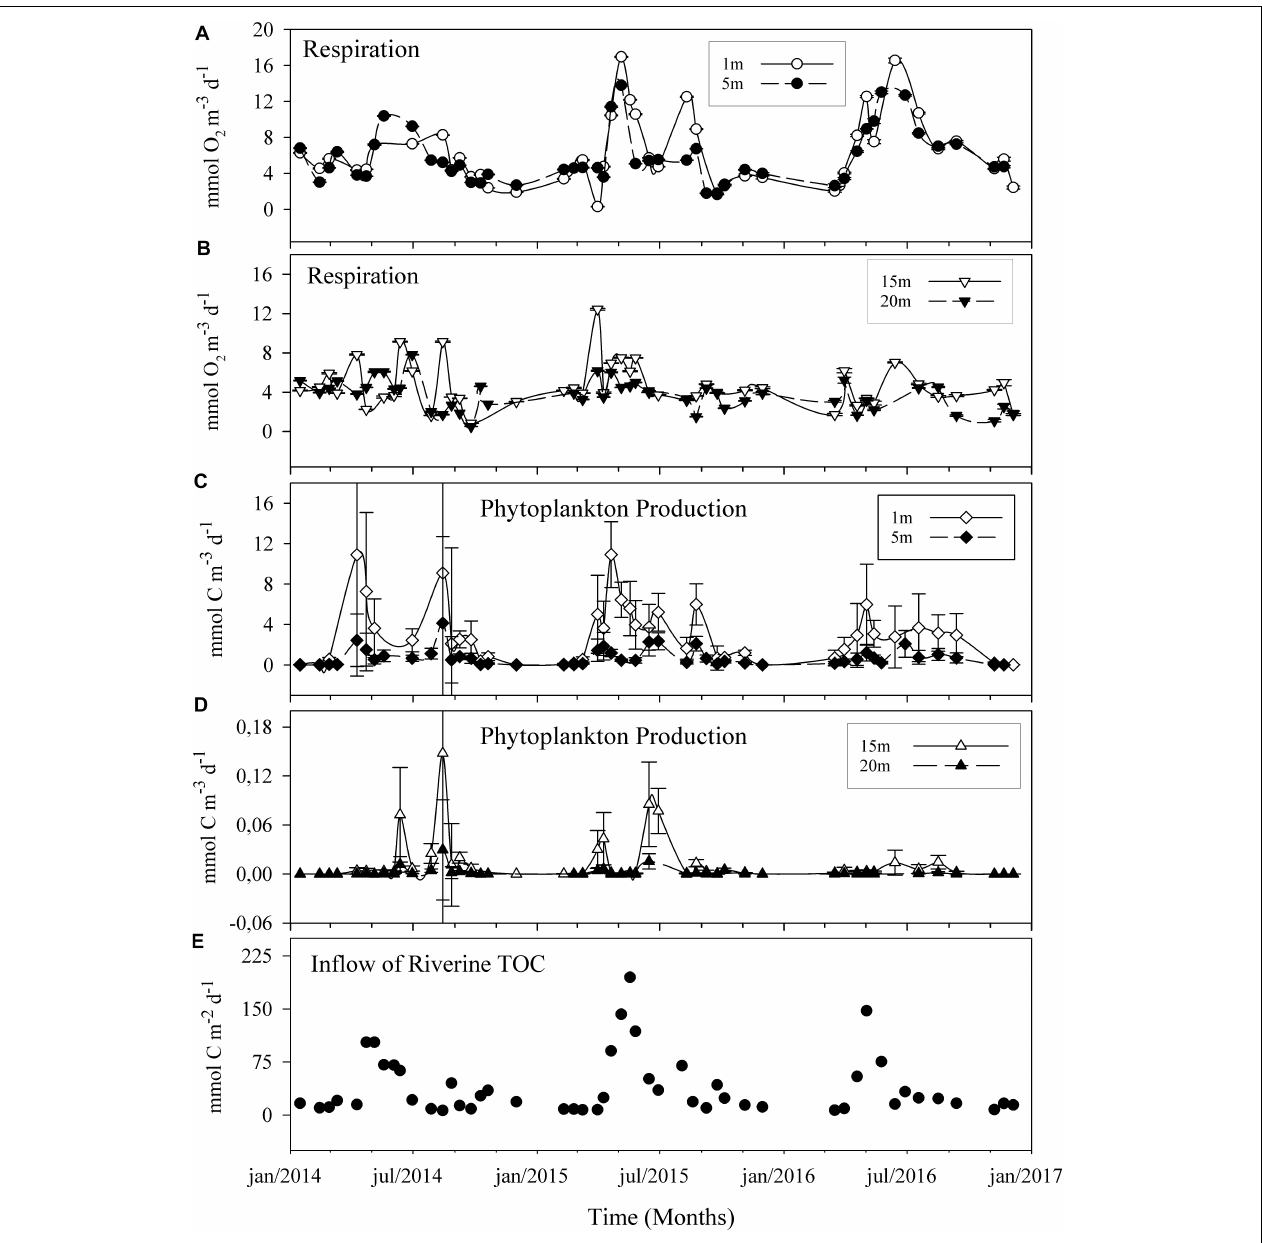
FIGURE 2 | Three-year time series of plankton respiration (A,B) and phytoplankton production (C,D) in the sub-arctic Öre estuary. Panels show the results for surface water ( ≤ 5 m, A,C ) and deep water ( ≥ 15 m, B,D ). Error bars show the analytical precision as 95% confidence limits (R) and 2 × SE (PhP), respectively. Error bars are smaller than the symbol where not visible. The lowest panel shows the inflow of total organic carbon from the Öre River (E) . Note the different scales for phytoplankton production > 15 m. Lines are based on a spline